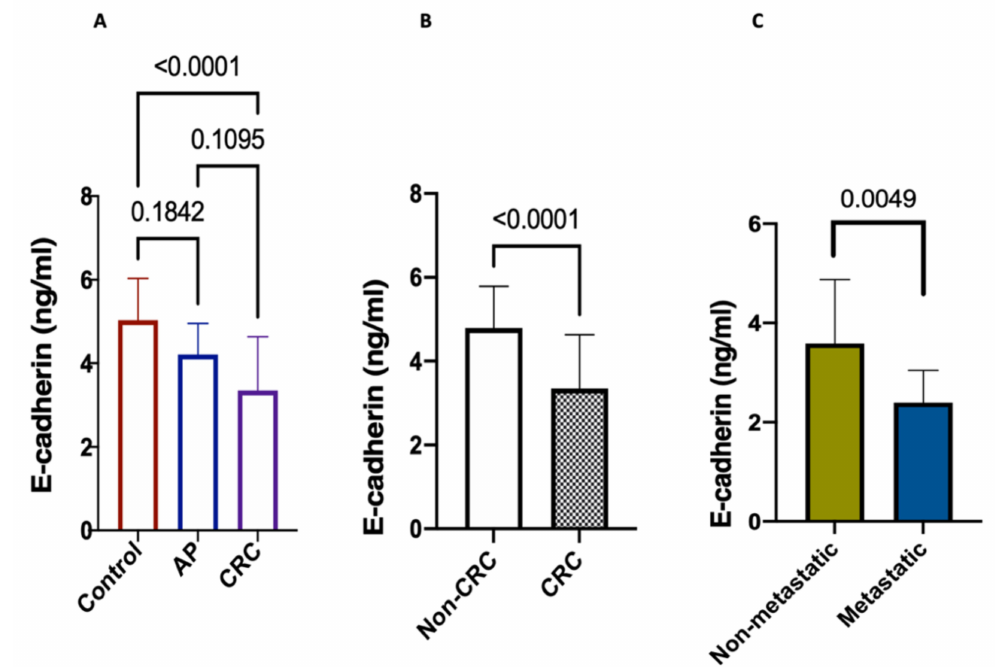
Figure 2. Serum levels of E-cadherin. Data expressed as mean ± SD. p < 0.05 means statistical significance. ( A ) CRC ( n = 140), adenomatous polyps ( n = 40) and healthy controls ( n = 100), ( B ) CRC ( n = 140) vs. non-CRC groups ( n = 140), ( C ) metastatic ( n = 24) vs. non-metastatic ( n =